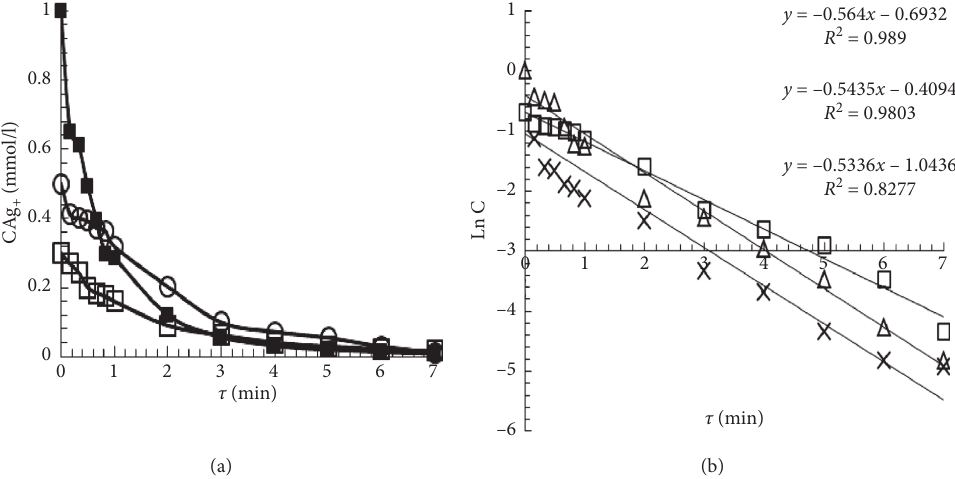
Figure 2: Dependence of equilibrium Ag + concentration and logarithm as a function of the duration of plasma discharge at different initial concentrations of silver ions in solution in the presence of PVA. Table 1: Size of silver nanoparticles obtained under the conditions of plasma treatment (Ag + /PVA) solution ( τ � 5min). C AgNO 3 (mmol/L)